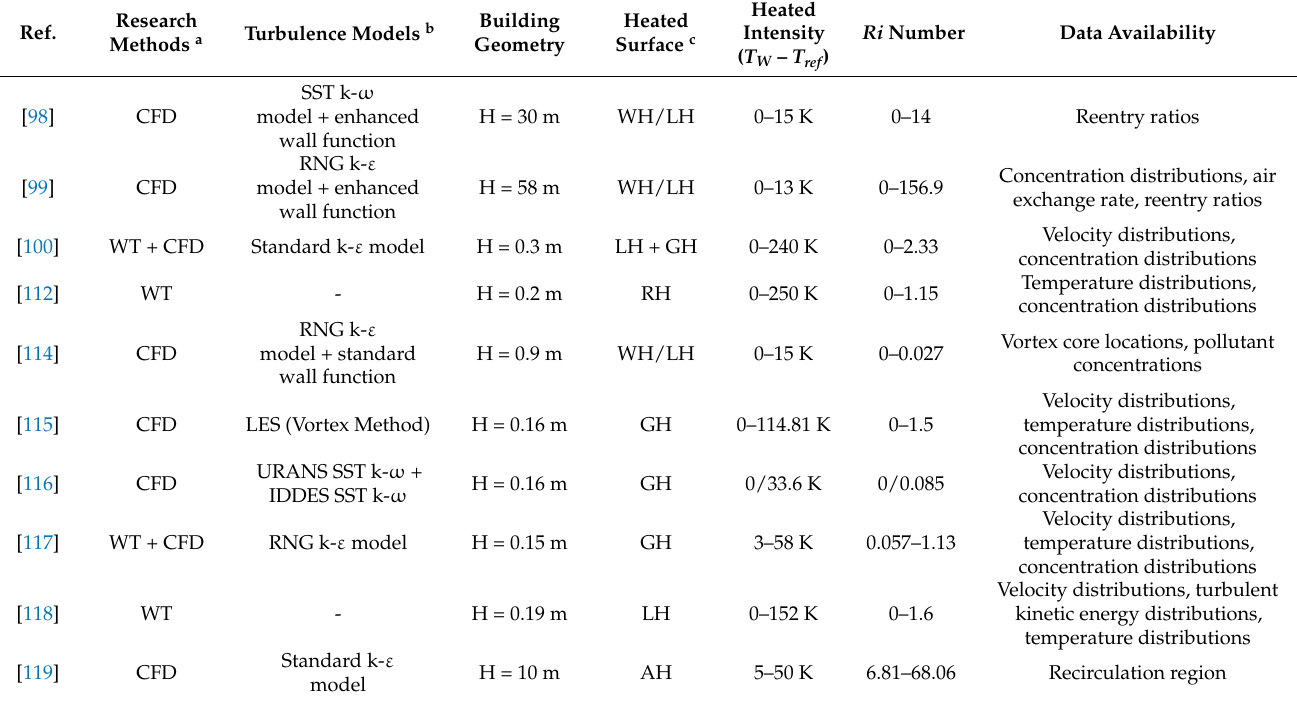
Table 2. Studies on thermal intensity under non-isothermal conditions around an isolated building.